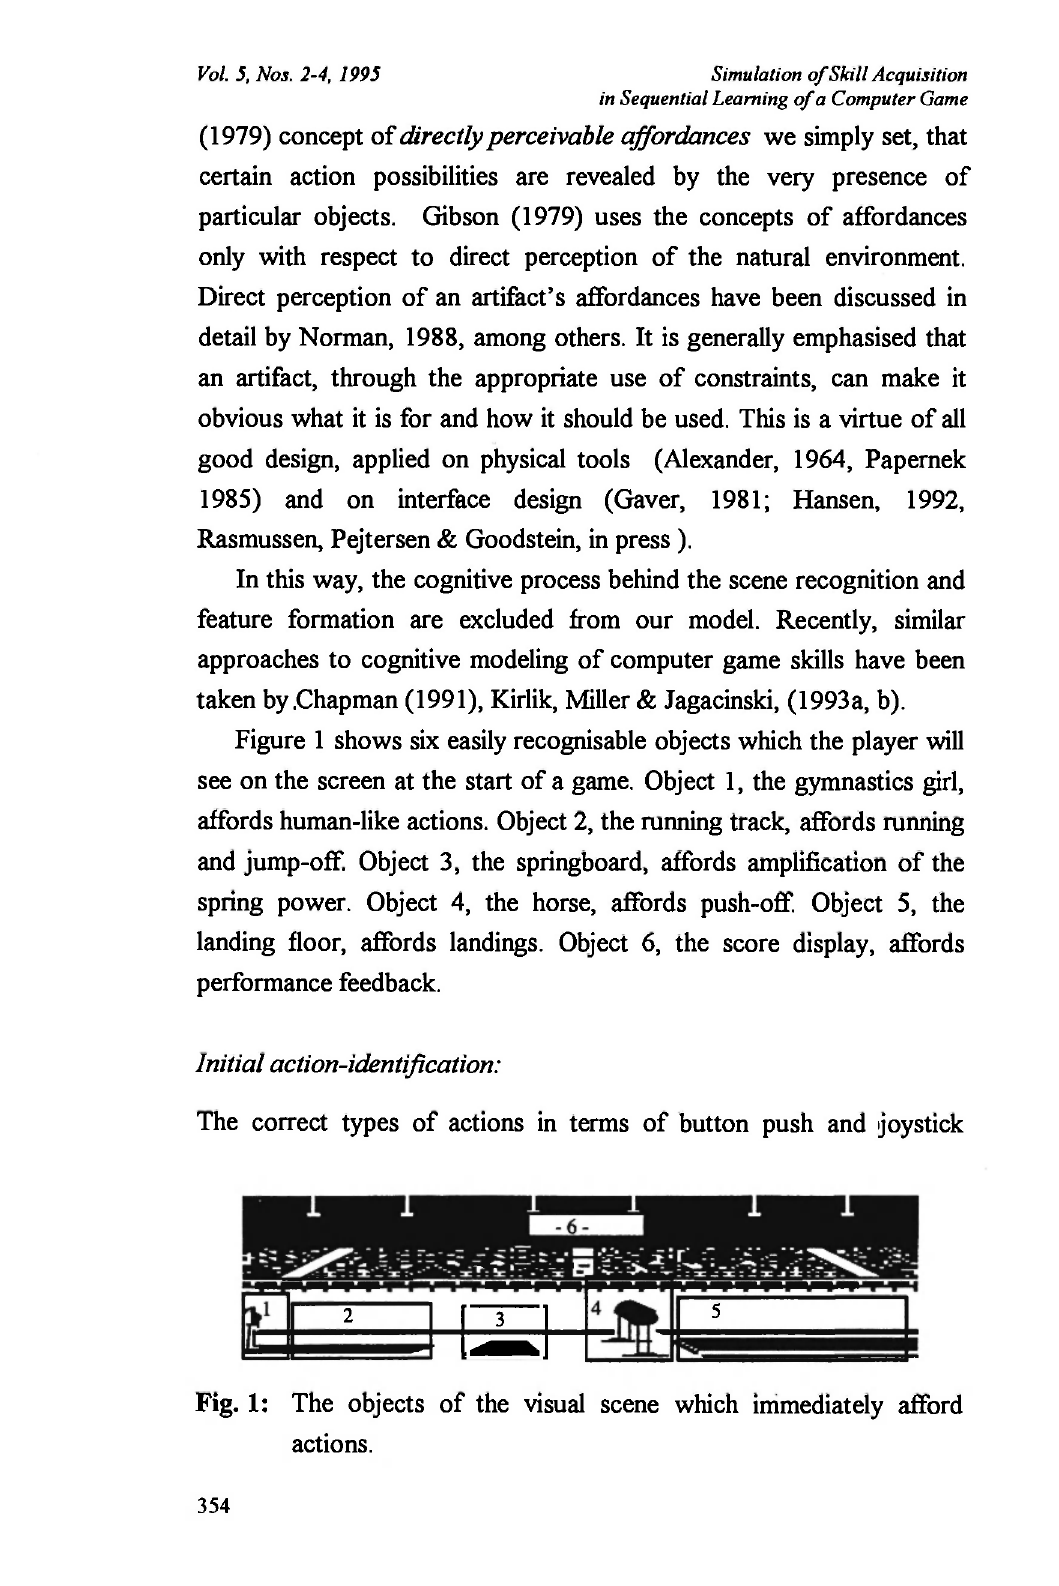
Fig. 1: The objects of the visual scene which immediately afford